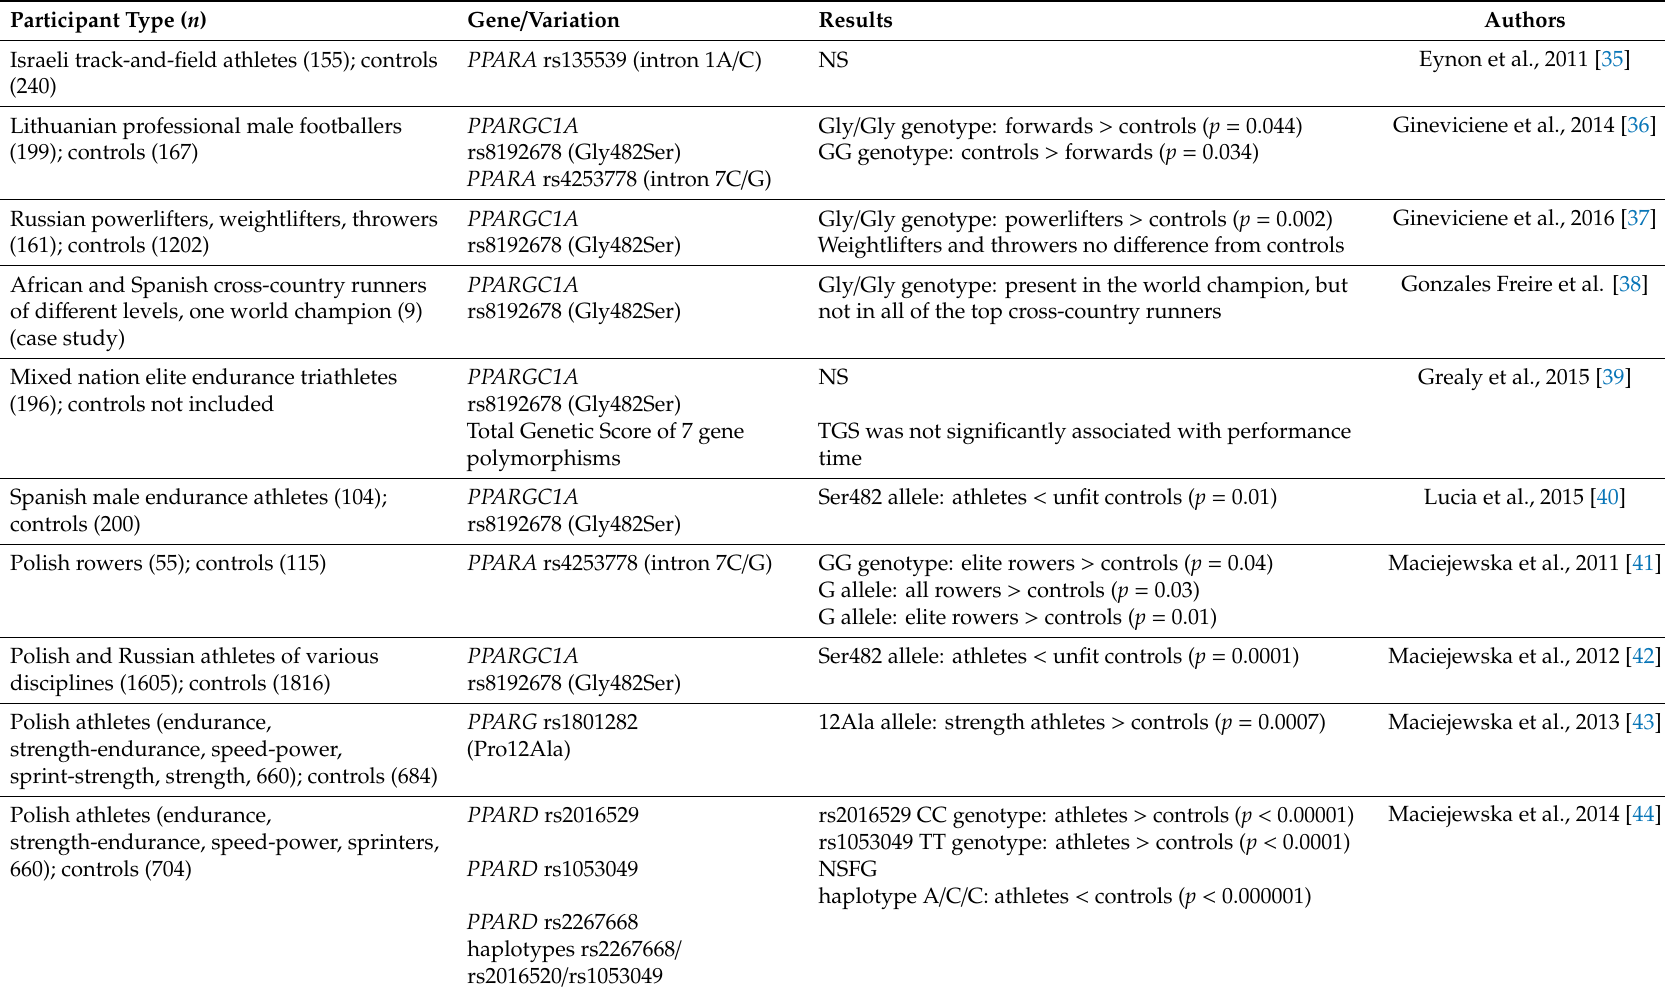
Table 3. Results for PPAR alleles and genotypes in elite athletes and